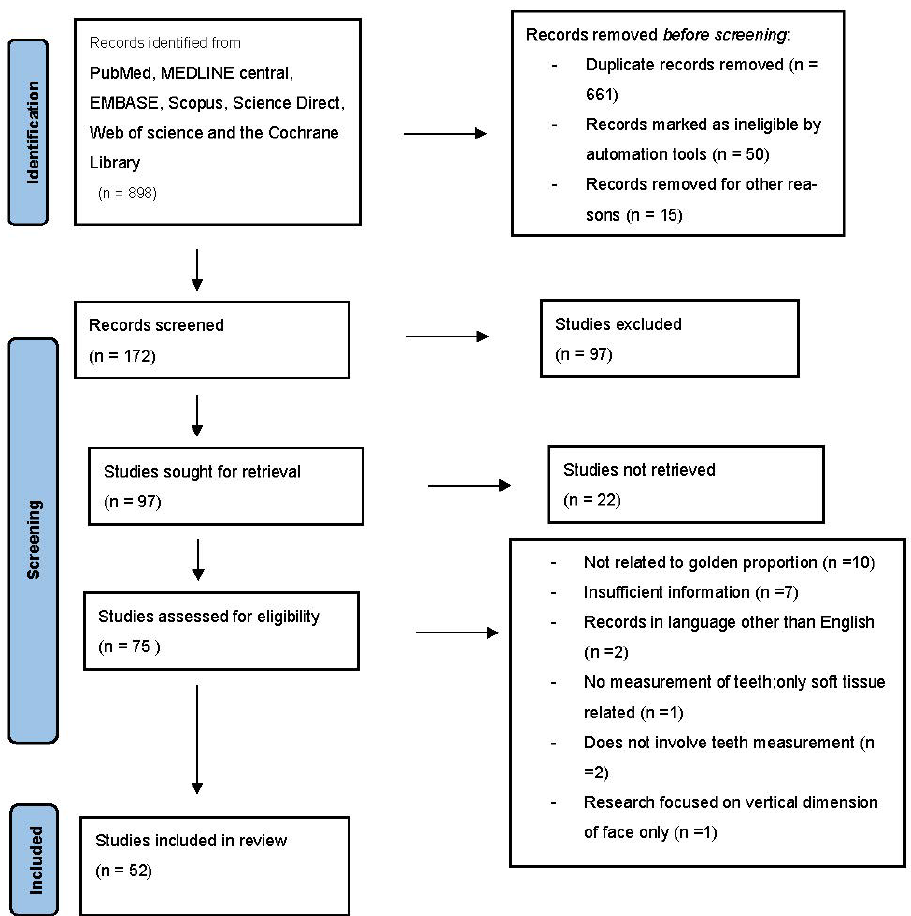
Figure 1. PRISMA flow diagram of study